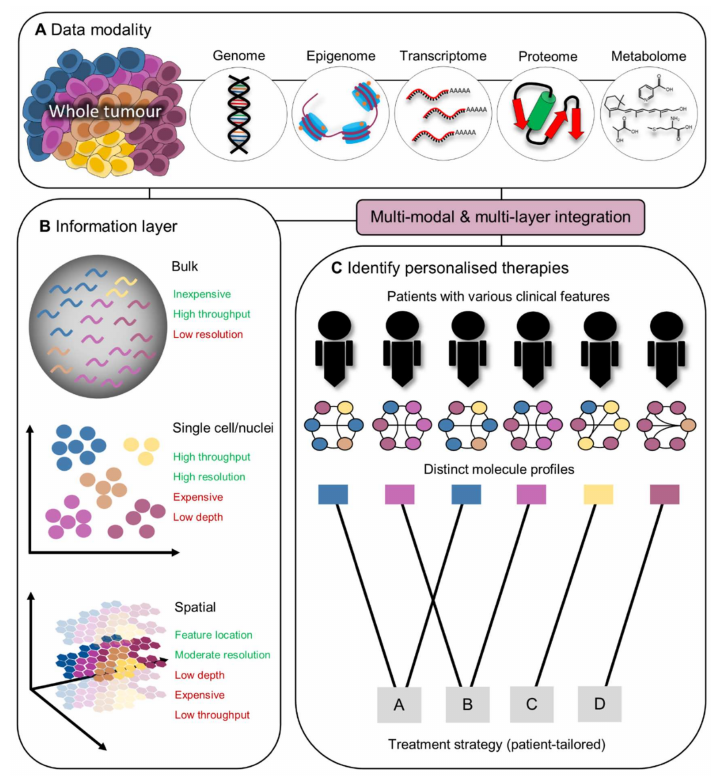
Figure 1. Leveraging the power of omics to guide personalised immunotherapy. ( A ) Whole tumours (and other sample types such as whole blood) contain all the fundamental modalities of informa- tion including the genome, epigenome, transcriptome, proteome, and metabolome. ( B ) Modern sequencing technology enables the extraction of information at various layers including bulk, single cell/nuclei and spatial. Each of these methodologies possess inherent disadvantages, however multi- ple layers can be combined in experiments to mitigate these issues. ( C ) By integrating the various modalities and information layers together, a comprehensive molecular snapshot can be obtained to develop patient-tailored therapies, maximising clinical